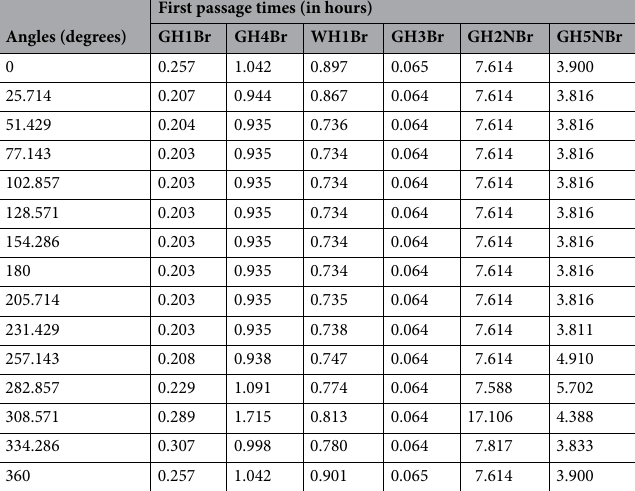
Table 3. Hornbill first passage times at fringes of home range for α = 8